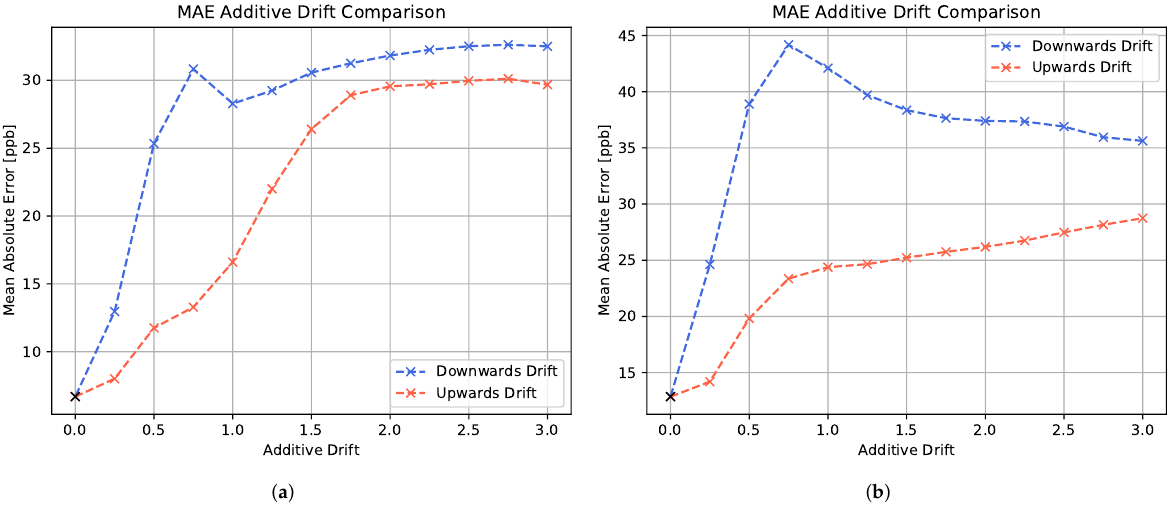
Figure 9. Comparison of the MAE metric performances of differently trained algorithms with respect to different levels of additive drift. The blue curve represents the downwards drift, whereas the red curve represents the upward drift performance. ( a ) shows the LSTM model and ( b ) the MLP model evaluation.